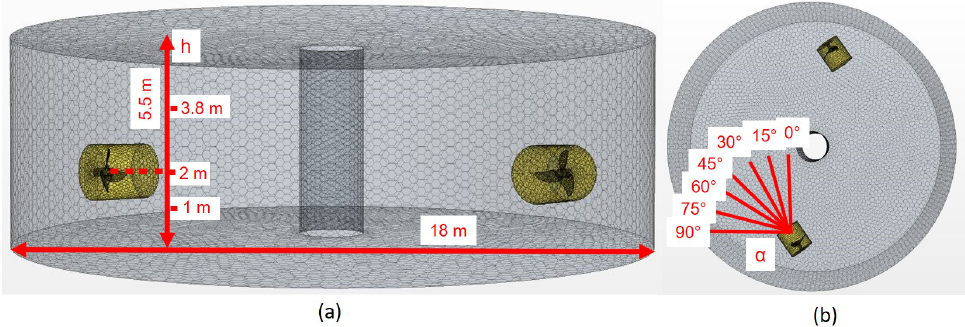
Fig. 1. 3D-CAD geometry of tank and propellers with meshing: (a) Side view with localization of stirrers at different heights h , and (b) top view with rotation of stirrers at different angles α